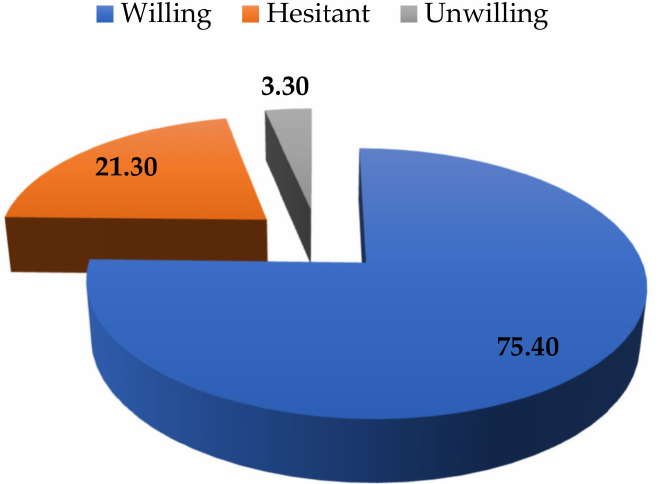
Figure 2. The parents’ willingness to vaccinate their children aged from 5 to under 12 years (measured in percentage). Source. Illustrated by the authors using the surveyed data. Table 1. Willingness of parents to vaccinate their children aged from 5 to under 12 years.